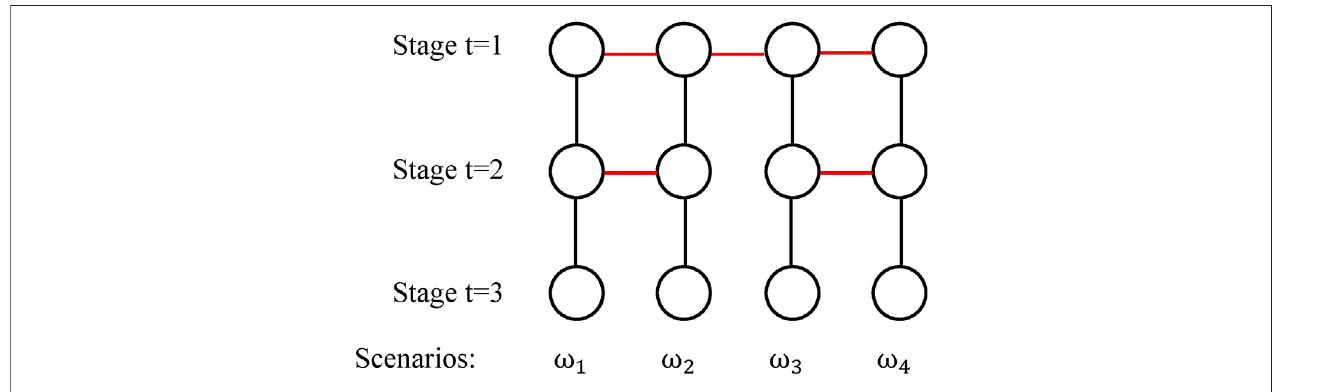
FIGURE 9 | An alternative form of the scenario tree with 3 stages, 4